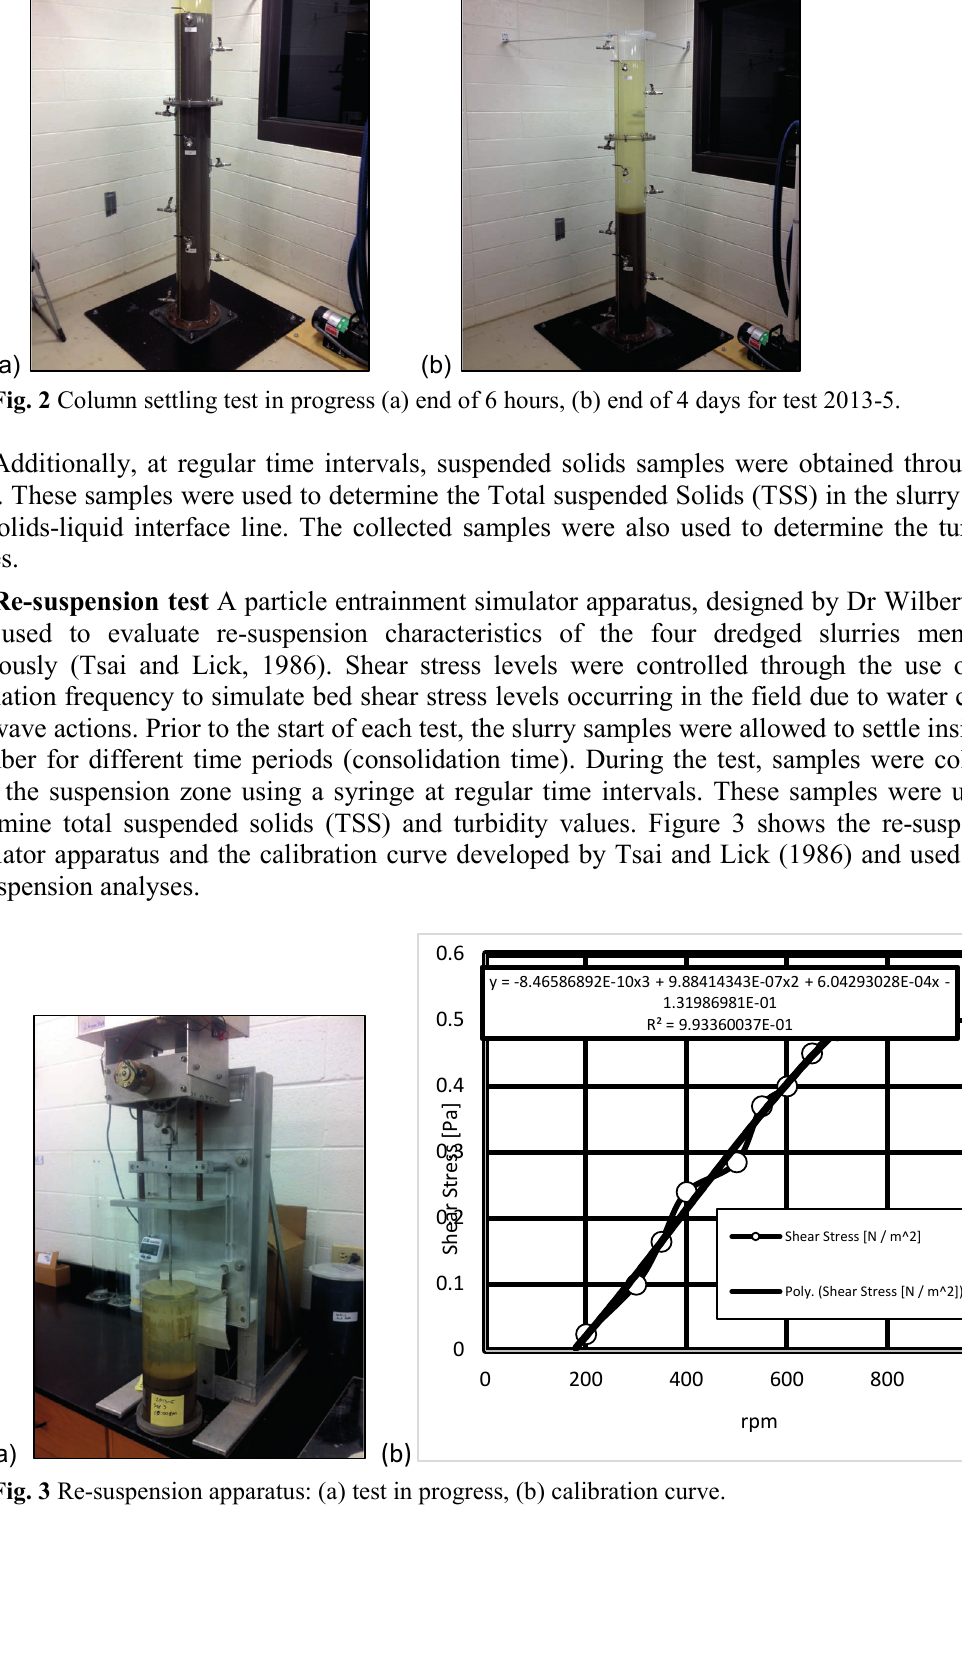
Fig. 3 Re-suspension apparatus: (a) test in progress, (b) calibration curve.